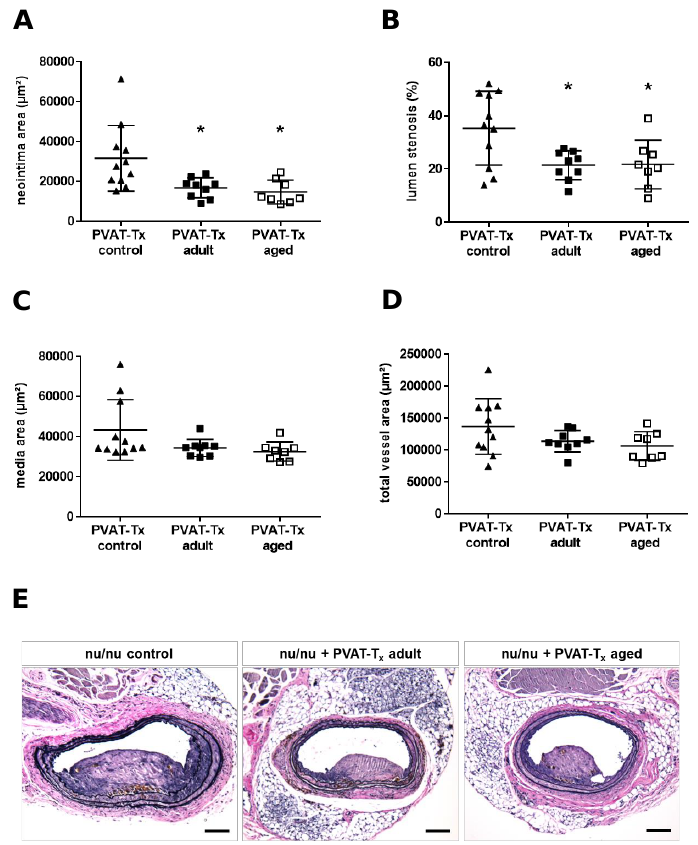
Figure 3. E ff ect of perivascular adipose tissue age on neointima formation. Vascular injury was induced at the carotid artery of NMRI nu / nu mice aged ten weeks immediately followed by transplantation (Tx) of PVAT freshly harvested from the thoracic aorta of adult ( n = 9) or middle-aged ( n = 8) C57BL6JRj mice. Nu / nu mice with their own PVAT left intact and not transplanted were used as control. Three weeks later, the neointima area ( A ), lumen stenosis ( B ), media area ( C ) and total vessel area ( D ) was morphometrically quantified on at least three VES-stained cross-sections and results averaged per mouse. Individual mean values per mouse and the mean ± SD are shown. * p < 0.05 vs. NMRI nu / nu not transplanted with PVAT (control; n = 11), as determined by the Kruskall-Wallis ( A , C ) or one-way ANOVA ( B , D ) test. Representative images are shown in ( E ). Size bars represent 100 µ